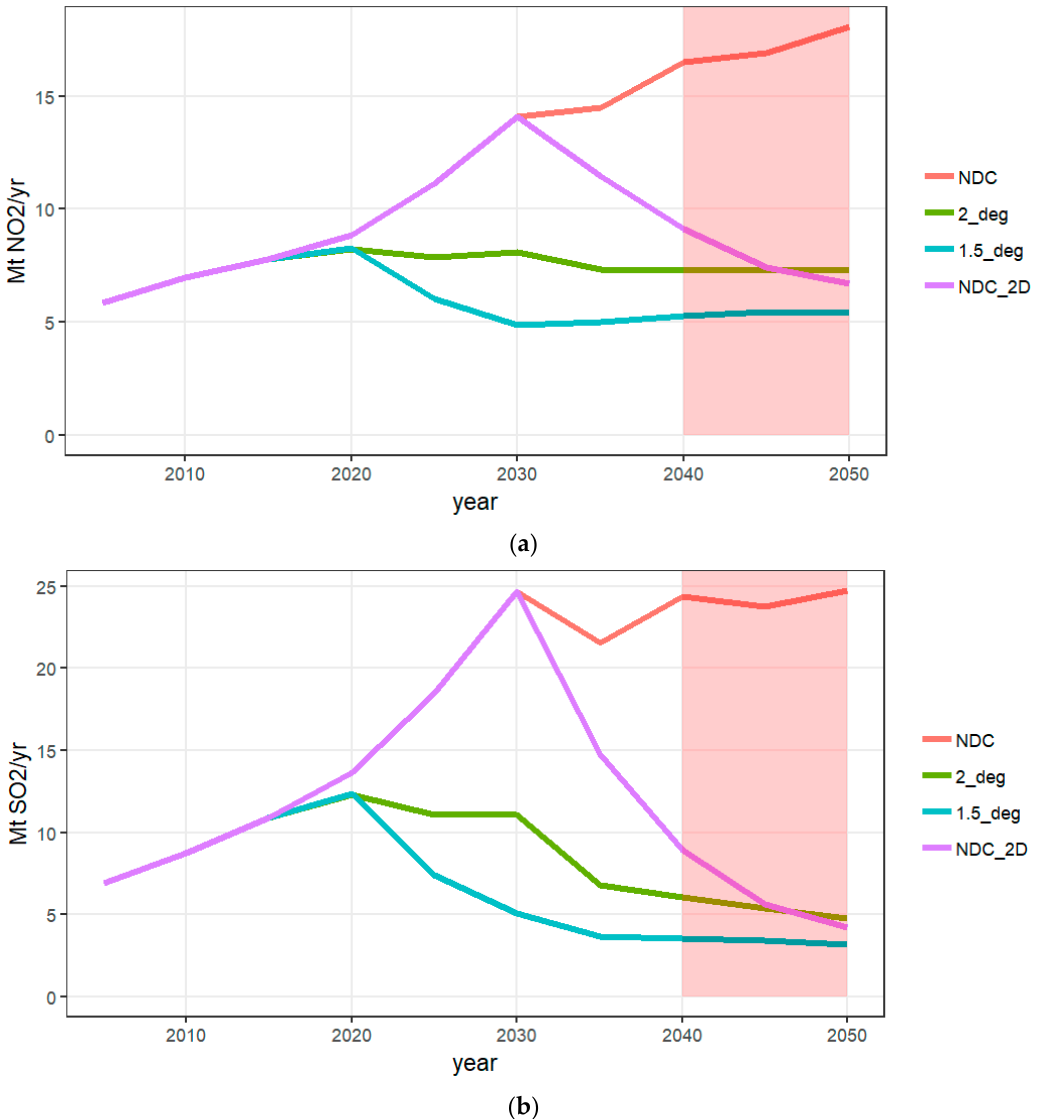
Figure 9. ( a ) NO x emissions (top) and ( b ) Sulfur emissions (bottom) in different scenarios.